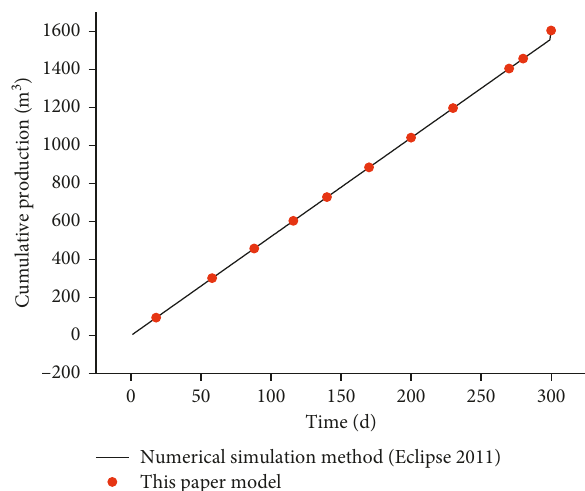
Figure 5: Comparison of the cumulative production from this paper model and numerical simulation (Eclipse 2011).